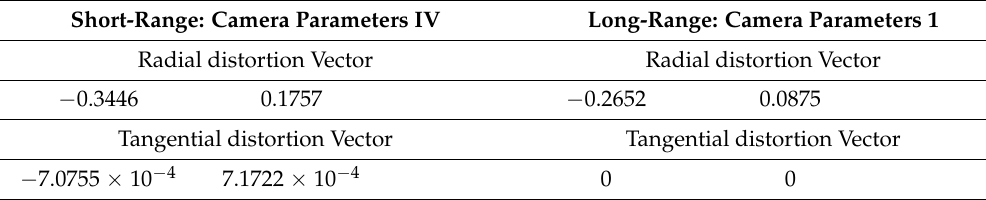
Table A3. Values of the calibration of the left camera for both measuring